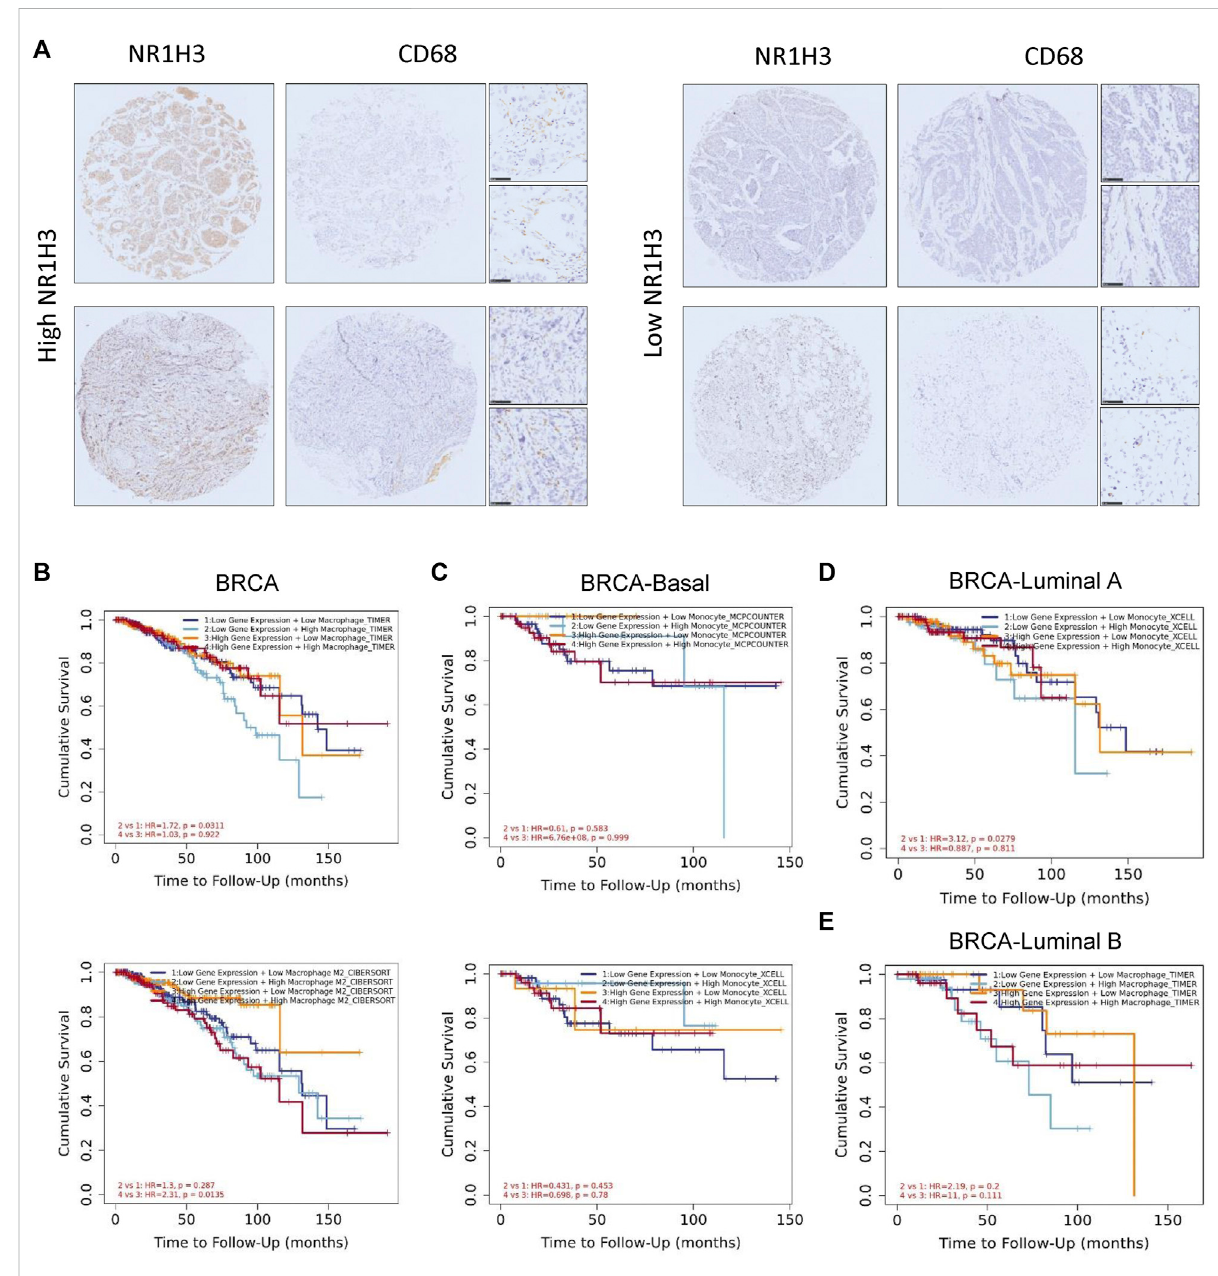
FIGURE 7 The survival curves, featuring patterns of NR1H3 gene expression and macrophage in fi ltration level were shown on the diagram. The association between macrophages and OS was displayed as thelow or high expression of NR1H3. (A) Representative IHC analysis ofNR1H3 and CD68, Scale bar = 50 μ m. (B) Kaplan-Meier curve for theNR1H3expressionlevel and macrophage in fi ltration using TIMER algorithmsinBRCA. (C) Kaplan-Meier curve for the NR1H3 expression level and monocyte in fi ltration using MCPCOUNTER algorithm in basal breast cancer. (D) Kaplan-Meier curve for the NR1H3 expression level and monocyte in fi ltration using XCELL algorithm in luminal A breast cancer. (E) Kaplan-Meier curve for the NR1H3 expression level and macrophage in fi ltration using TIMER algorithm in luminal B breast cancer. OS, overall survival; IHC,